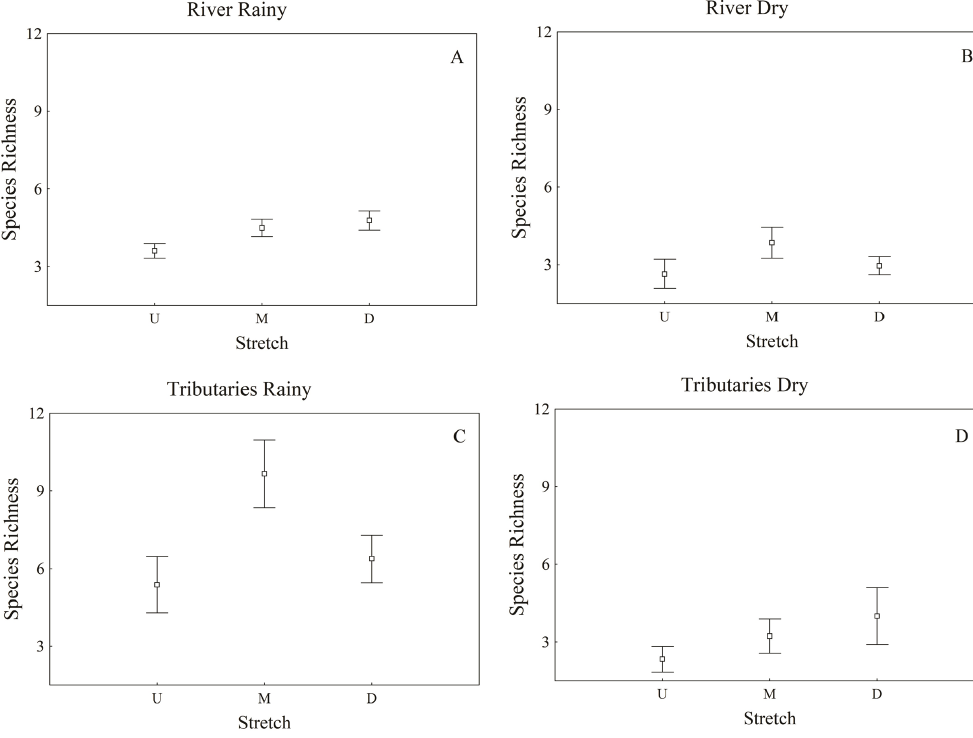
Figure 3. Ciliate species richness registered in the Paraná River during the rainy (A) and dry (B) periods and its tributaries during the rainy (C) and dry (D) periods in each stretch – upstream (U), middle (M), and downstream